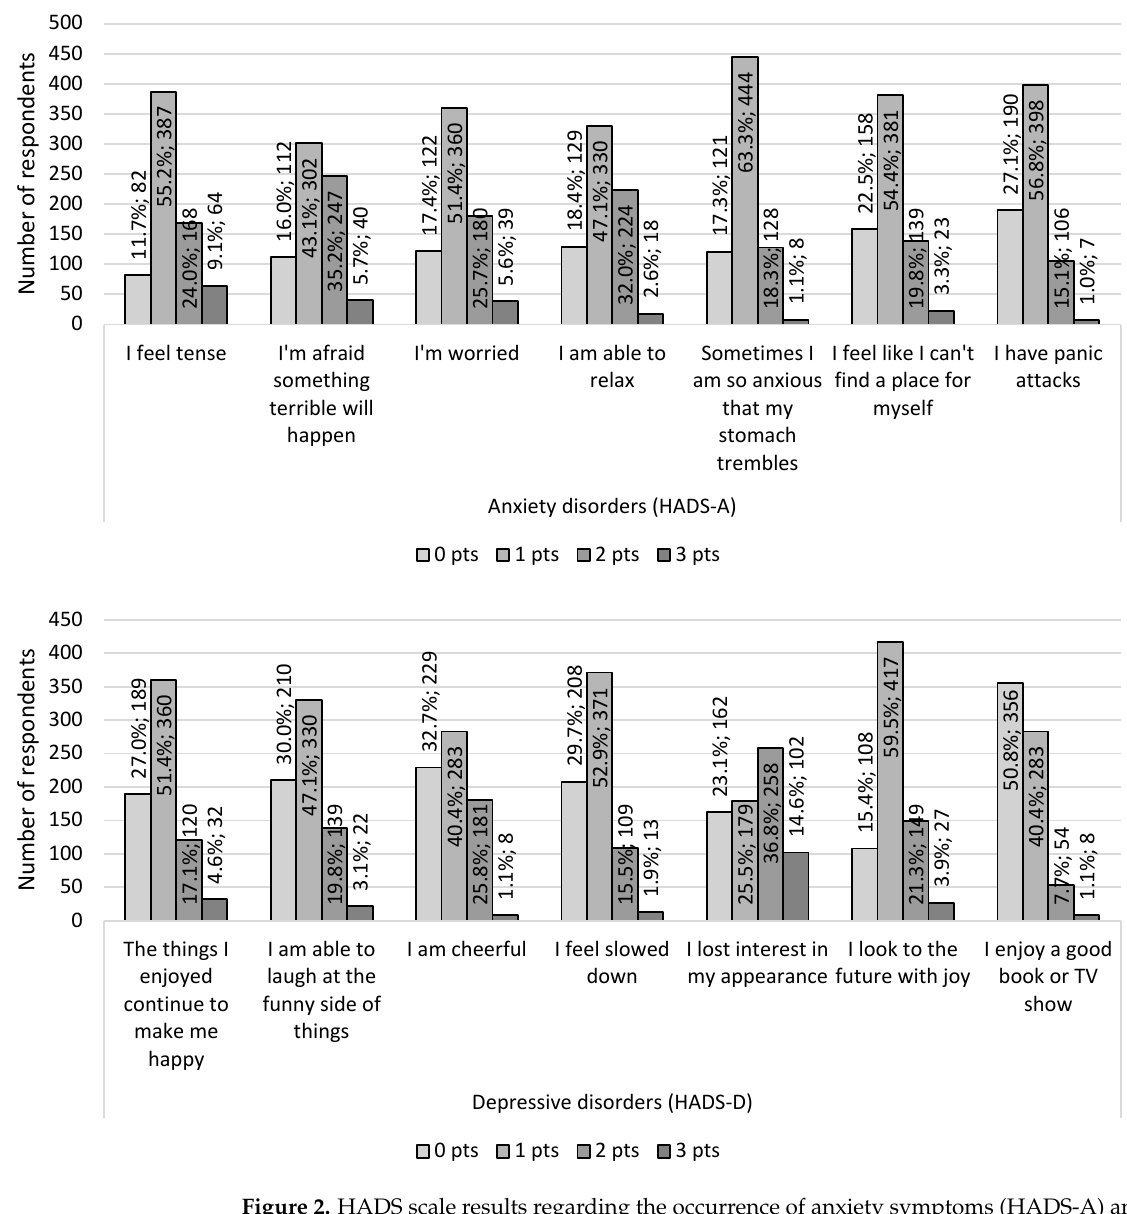
Figure 2. HADS scale results regarding the occurrence of anxiety symptoms (HADS-A) and depres- sive symptoms (HADS-D) in the group of examined doctors (N = 701; 100%). The severe intensification of anxiety symptoms affected the elderly ( n = 79; 16.1% vs. n = 102; 48.8%; p < 0.0001) significantly more frequently, and this was similar for severe depressive symptoms ( n = 49; 10.0% vs. n = 86; 41.1%; p < 0.0001). Therefore, the presented results of the analysis were considered for separate age groups. A significantly higher risk of anxiety symptoms was observed among overweight, obese, married, divorced, and widowed people living in houses. On the other hand, a good economic status was associated with a reduced risk of developing anxiety symptoms. Similar observations were observed for the risk of depressive symptoms (Table 2). Then, the following factors related to the working environment appeared to be significant for the increased risk